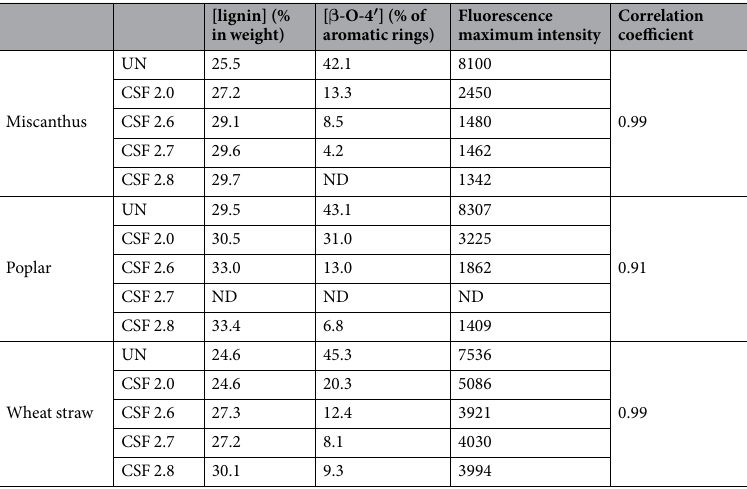
[lignin] (% in weight)